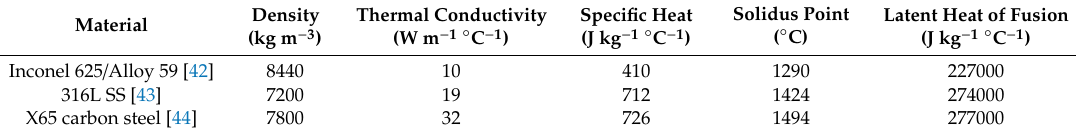
Table 2. Summary of thermophysical properties for Ni-based alloys and various steels.